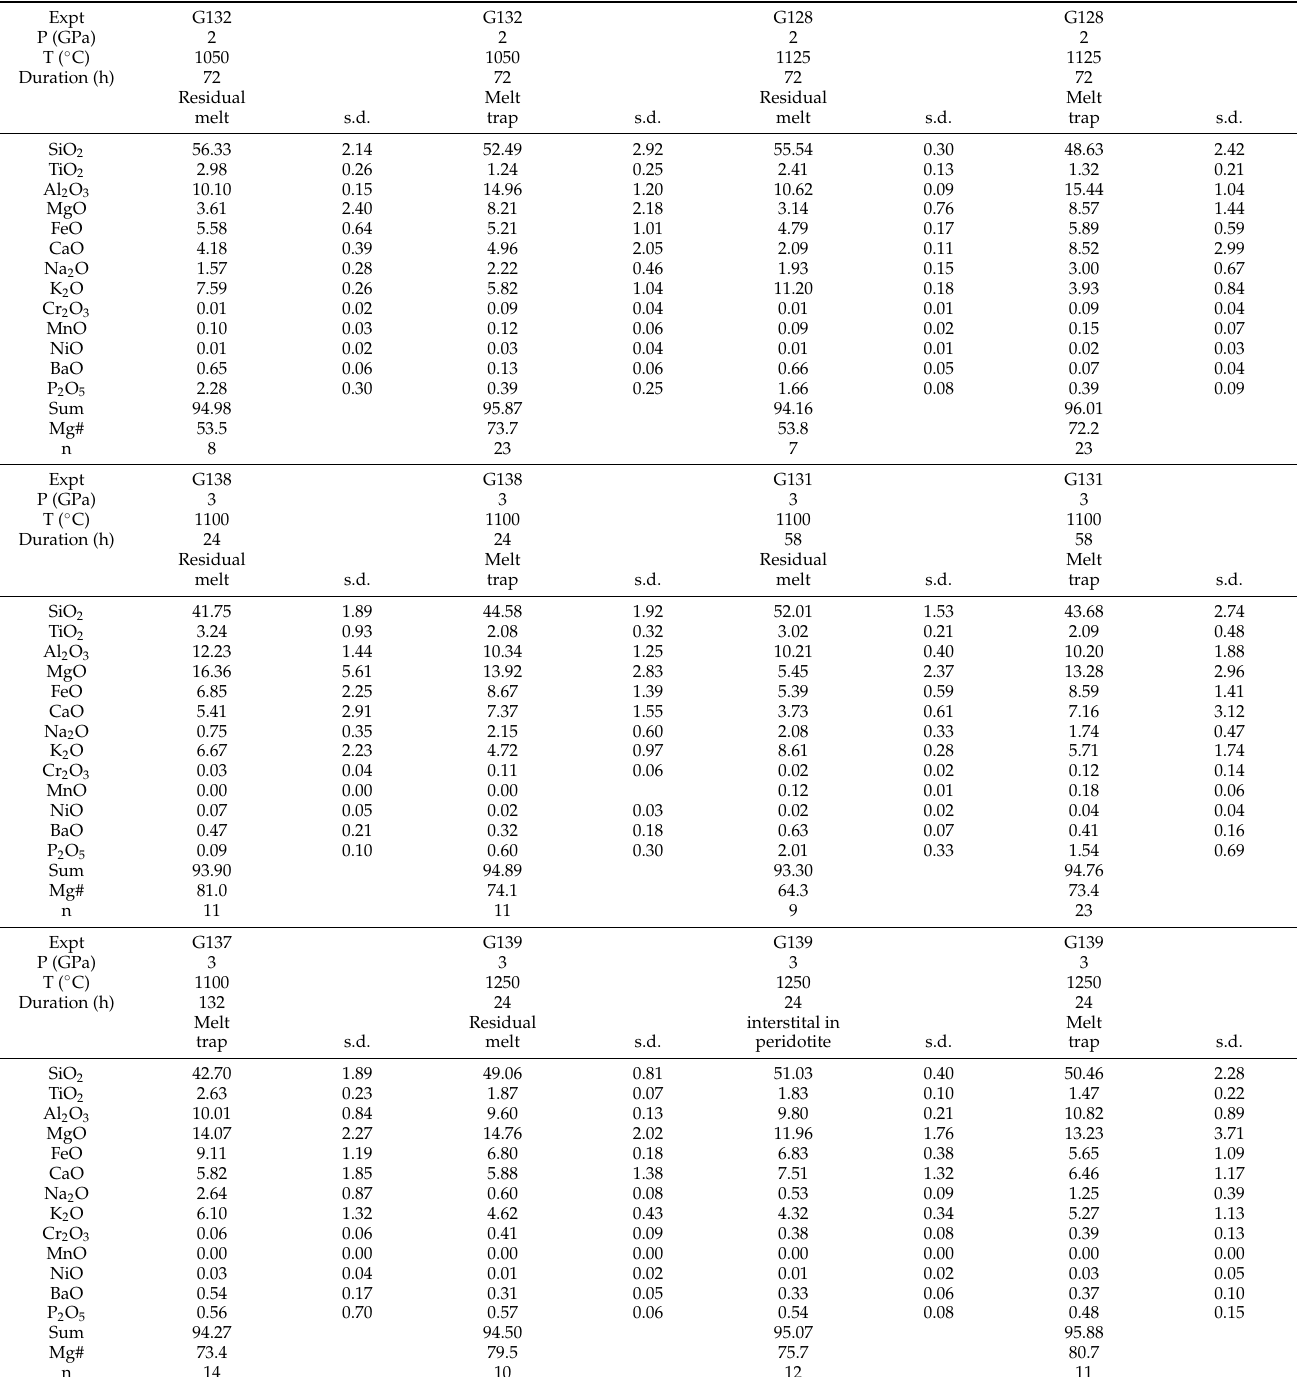
Table 5. Melt compositions in dynamic metasomatism